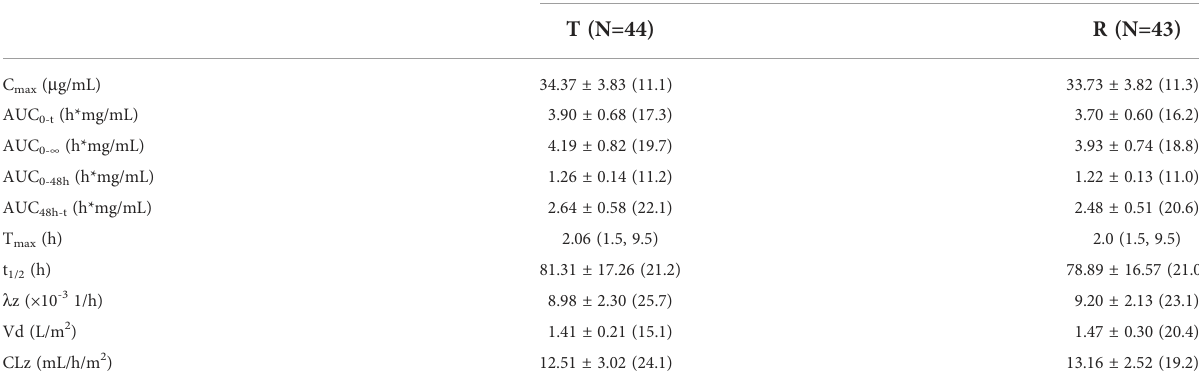
TABLE 4 The PK Parameters of Encapsulated